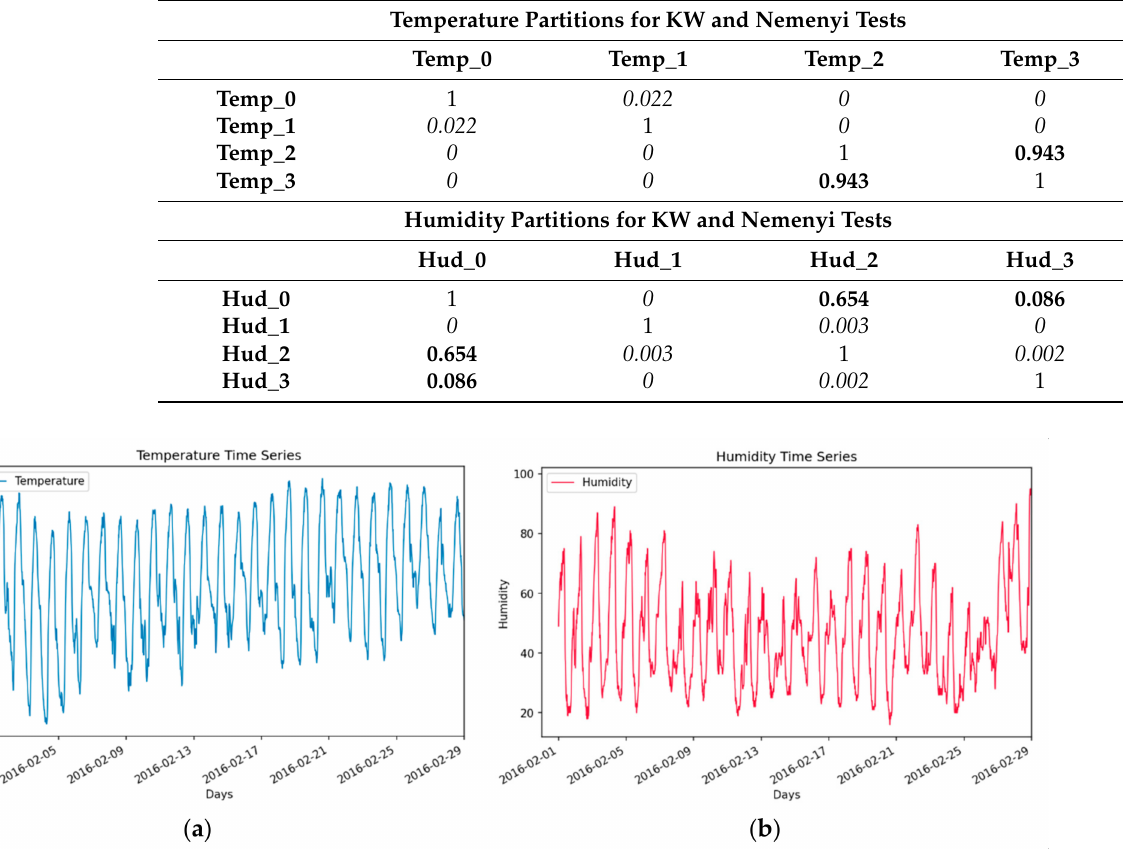
Figure 3. Pre-processed univariate timeseries datasets collected over a period of one-month (1 February 2016 to 29 February 2016) ( a ) Temperature Time Series ( b ) Humidity Time